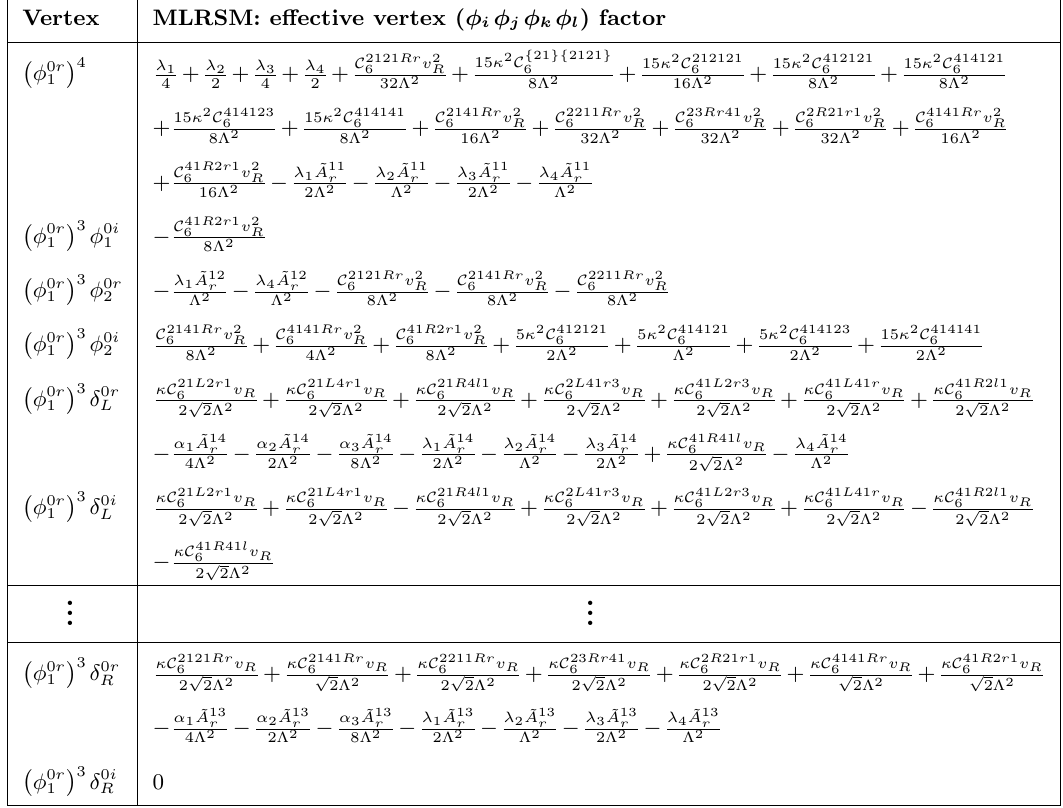
Table 50. MLRSM: scalar four-point vertices in the unphysical basis. As the number of such kind of vertices are very large, we have not mentioned all of them. These vertex factors are computed with the following assumptions: (cid:20) 1 = (cid:20) 2 = (cid:20); v L = 0. In these limits we have rede(cid:12)ned A ij ~ A ij ; ~ A ij r i